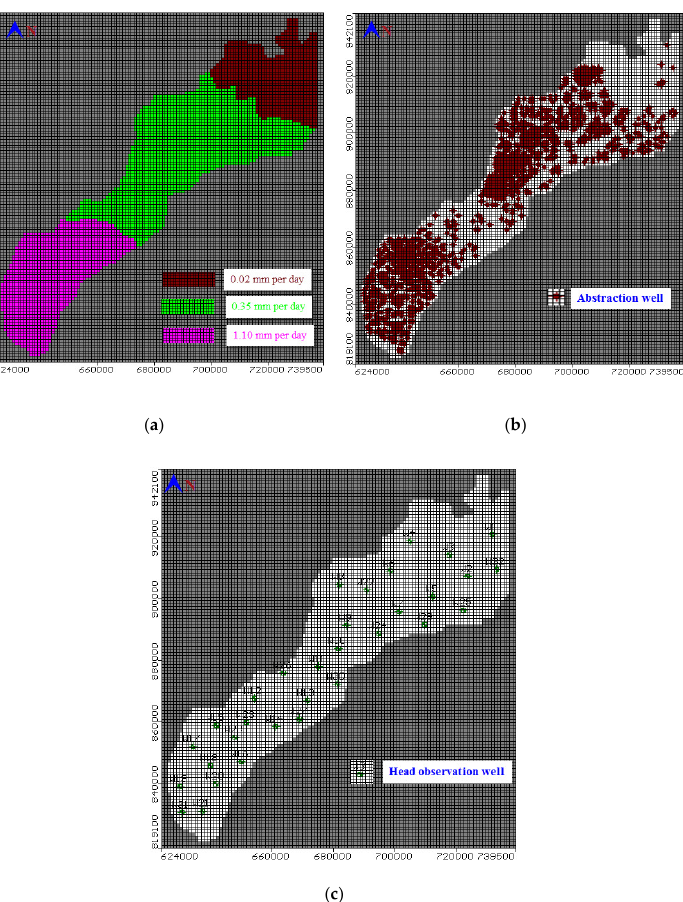
Figure 4. Model ( a ) net recharge, ( b ) abstraction wells, and ( c ) observation head wells .